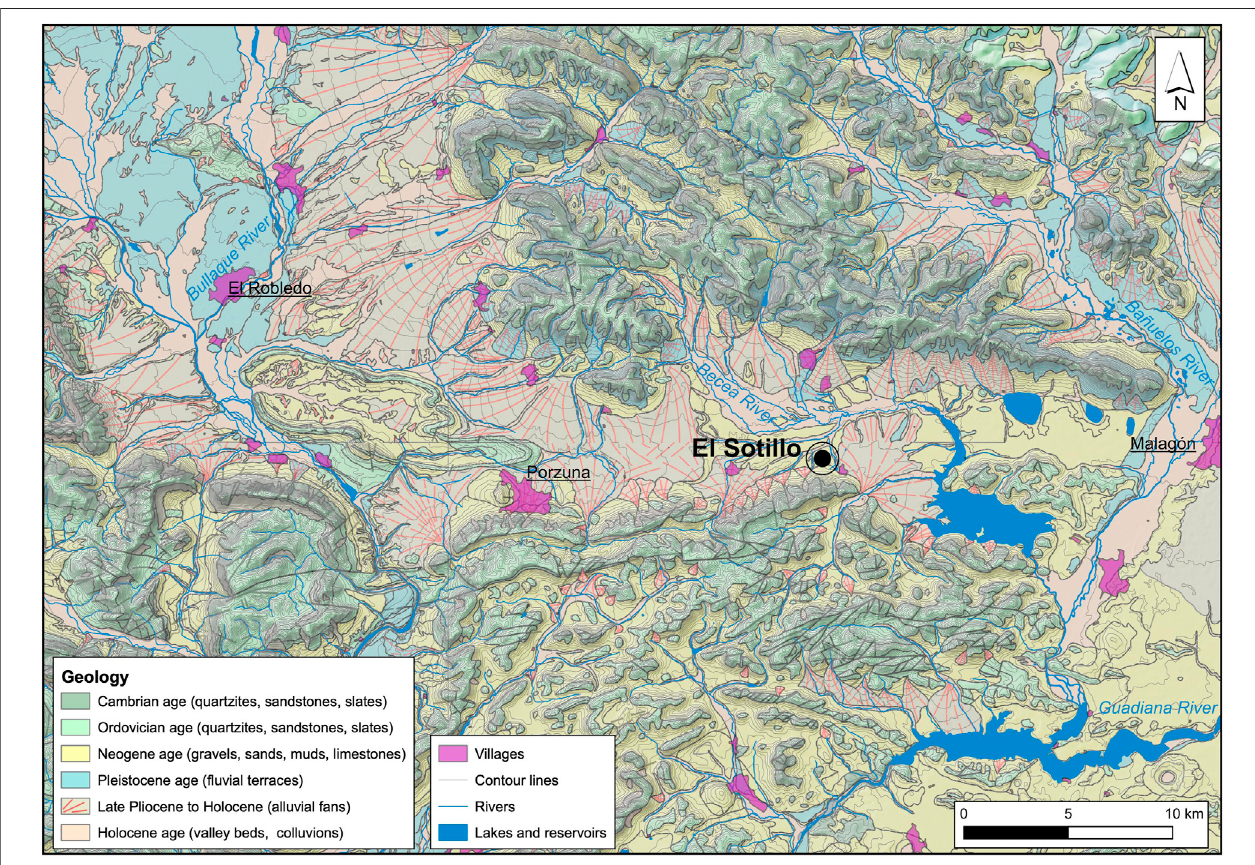
FIGURE 2 | Geological framework of the El Sotillo site (645 m. a.s.l.) in the Porzuna - Malagón synclinorium, with the Malagón quartzite hill (1070 m. a.s.l.) to the northandtheElSotillosierra(890 m.a.s.l.) tothesouth.ThePorzuna-MalagónsynclinoriumiscrossedfromW-EbytheBeceaRiver,atributaryontherightbankofthe Bañuelos River, which is, in turn, a tributary of the Guadiana River. Map made with data layers provided by IGME.